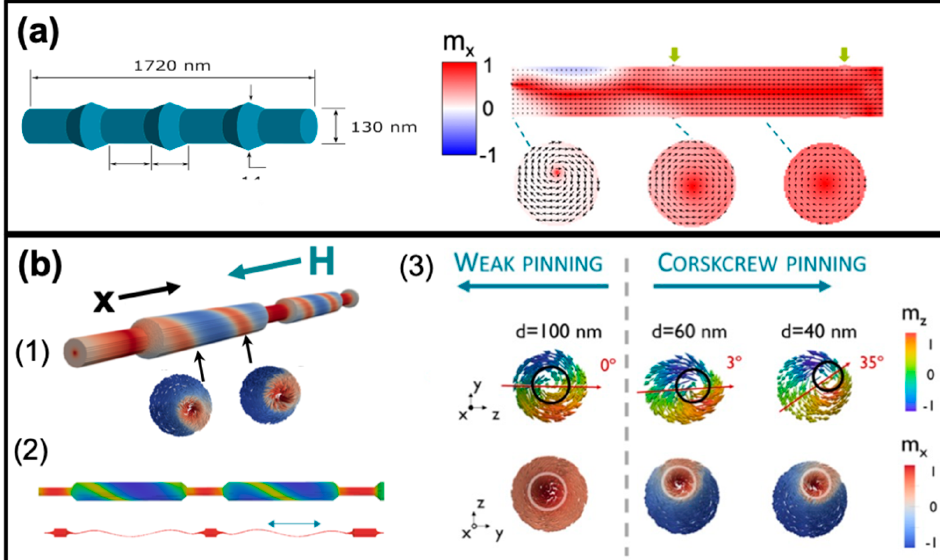
Figure 10. ( a ) Geometry of a FeCo nanowire with anti-notches (bamboo-type nanowire) on the left side and, a snapshot of one end of the nanowire at the remanent state on the right (Adapted with permission from ref. [21]. Copyright 2016 Royal Society of Chemistry.). The green arrows indicate the position of the anti-notches. The dashed lines show the location of the cross-sections. ( b ) (1) The magnetization at the surface of a modulated nanowire with segments of 130 nm in diameter and a smaller diameter d in a magnetic state before magnetization switching. The cross-section taken at the positions marked by arrows shows the skyrmion tube state. (2) The core of the skyrmion describes a helicoidal curve inside the segments of larger diameter. The segments of minor diameter remain uniformly magnetized. (3) magnetization configurations in the cross-sections of the segments with larger diameters in nanowires with segments of smaller diameters. Adapted with permission from ref. [39]. Copyright 2018 Royal Society of Chemistry.